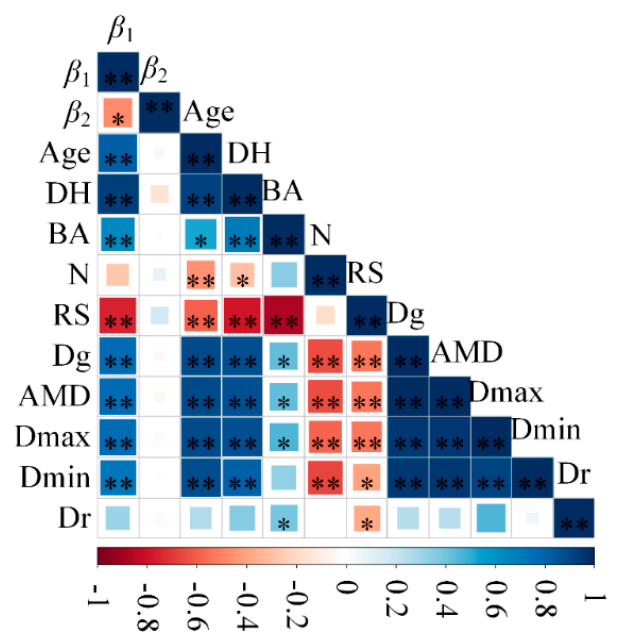
Figure 2. Correlation among the stand-level predictor variables and basic height-diameter (H-D) model coefficients. Age is the stand age; DH is the dominant height; BA is the basal area per hectare; N is the stand density; RS is the relative spacing; Dg is the stand quadratic mean diameter; AMD is the stand arithmetic mean diameter; Dmax and Dmin are the maximum and minimum diameter of the plot, respectively; Dr is diameter range per plot; β 1 and β 2 are model parameters. * and ** denote the significant correlation at level of p < 0.05 and p < 0.01, respectively.